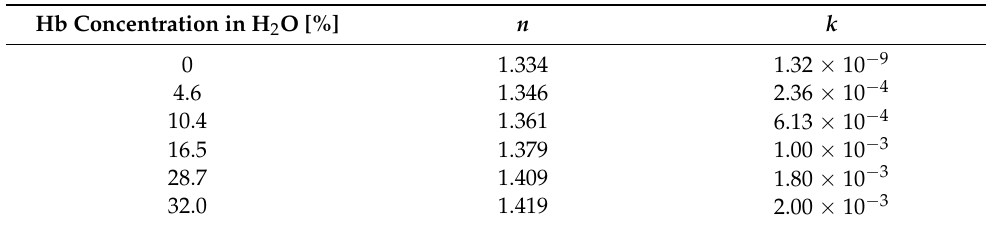
Table 1. Refractive Indices n and Extinction Coefficients k of Hb solutions in water [19,60].